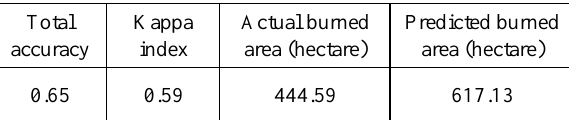
Table 5. Results of comparison of real and simulated fire